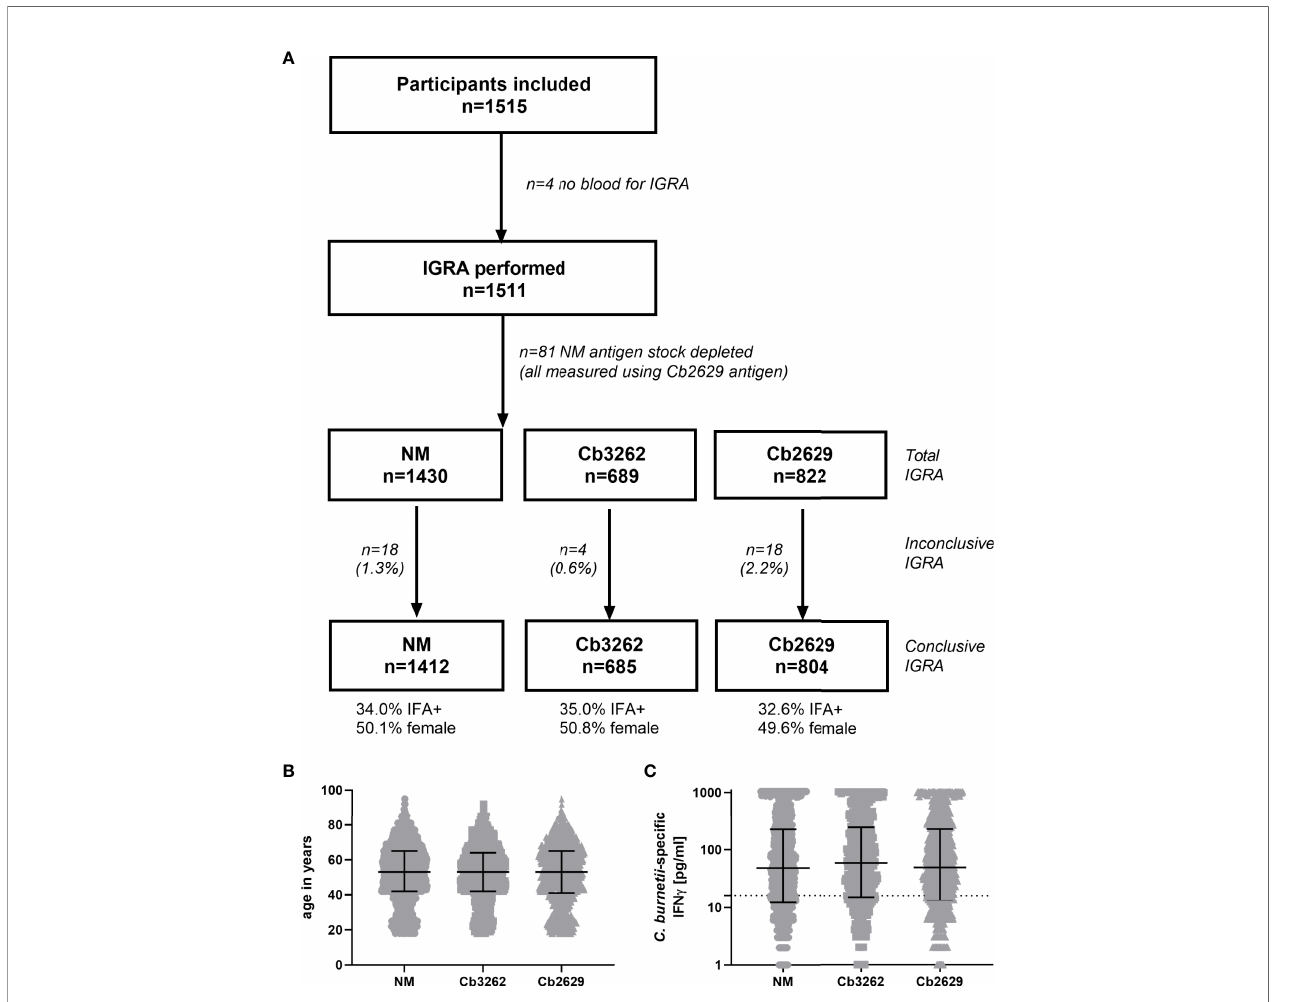
FIGURE 1 | Flowchart, demographics and magnitude of C. burnetii- speci fi c IFN g responses of subjects analyzed by IGRA using the three different strains of C. burnetii . (A) Flowchart of subjects subjected to IGRA stimulations with the three C. burnetii strains including proportion of gender and IFA positivity amongst subjects with a conclusive IGRA result. (B) Age distribution and (C) C. burnetii -speci fi c IFN g response (background-corrected) in individuals with a conclusive IGRA result for NM (n=1412), Cb3262 (n=685) and Cb2629 (n=804). B and C show individual data with medians and interquartile ranges. The dashed line indicates the positivity cut-off of 16 pg/mL for C. burnetii speci fi c IFN g production.